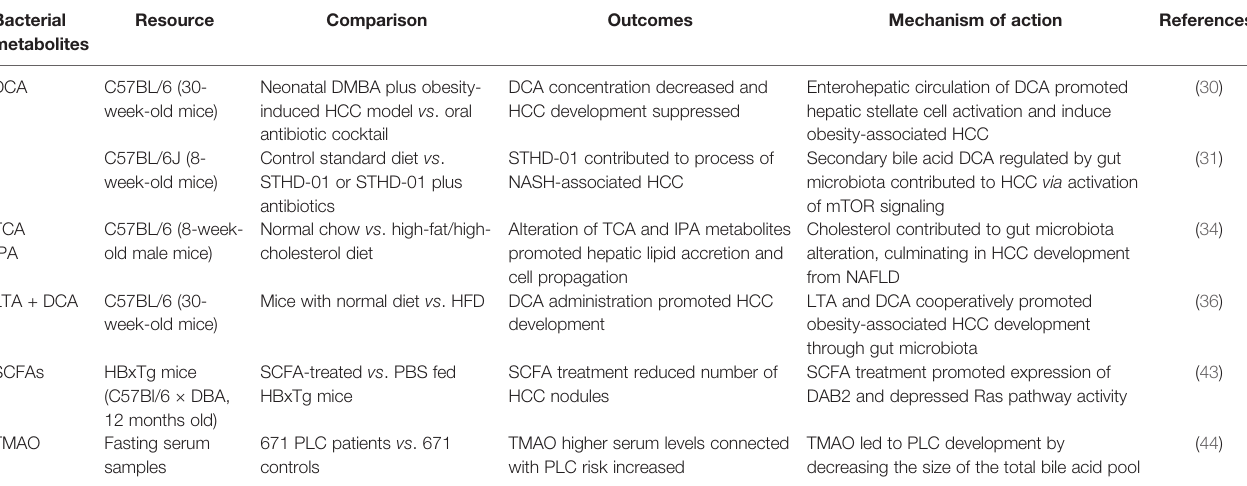
TABLE 1 | Dysbiosis of bacterial metabolism and hepatocarcinogenesis. Bacterial